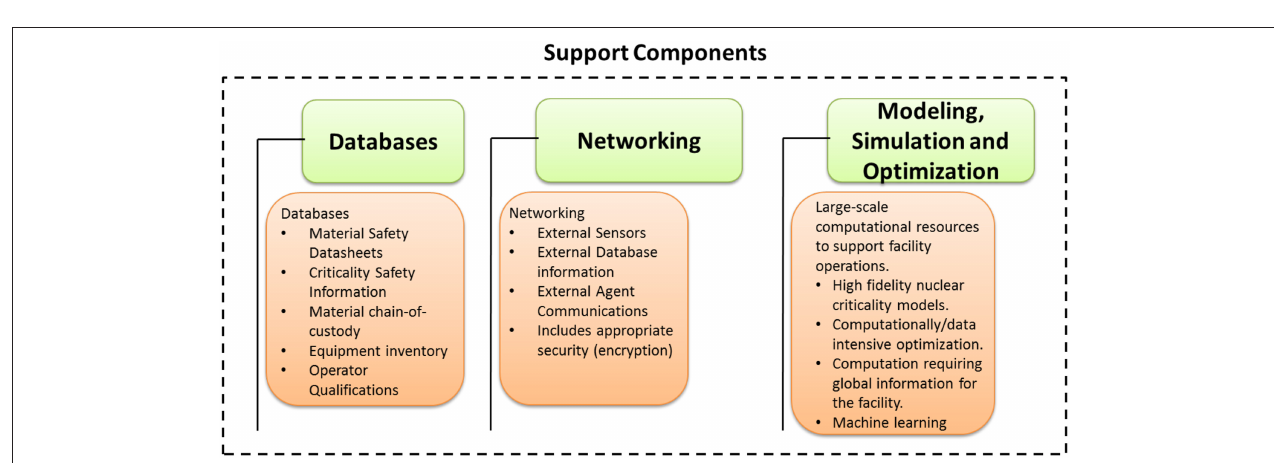
FIGURE 5 | The software framework for the system. These are the primary components that the user interacts with.